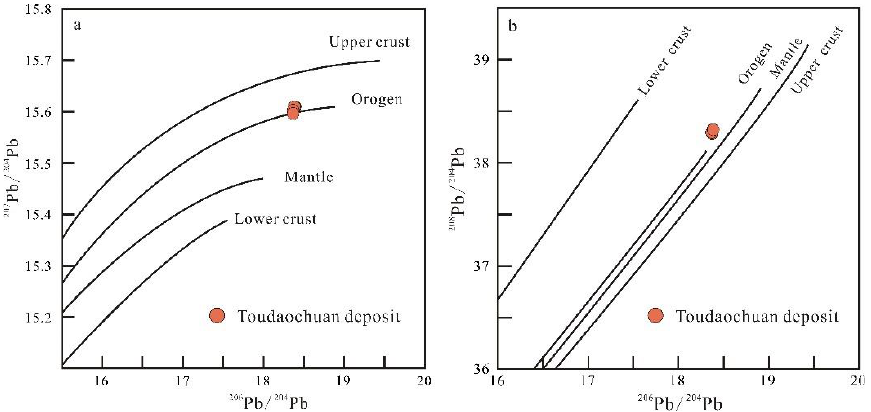
Figure 11. ( a , b ) Lead isotopic composition for the Toudaochuan deposit (after Zartman and Doe [54]).